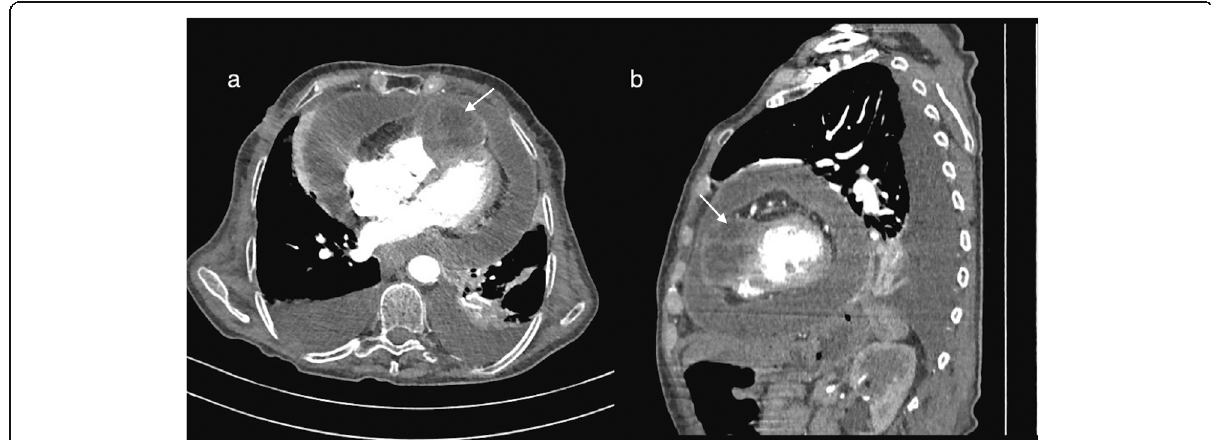
Fig. 1 Appearance of massive pericardial effusion with hydatid cyst compressing the right ventricle (arrows) at CT scan. a Transversal view. b Sagittal view